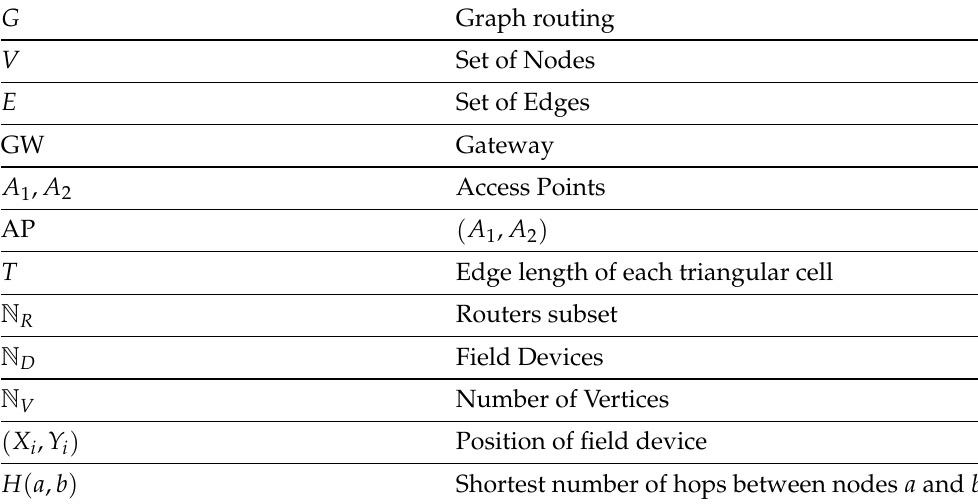
Table 2. Variables and symbols